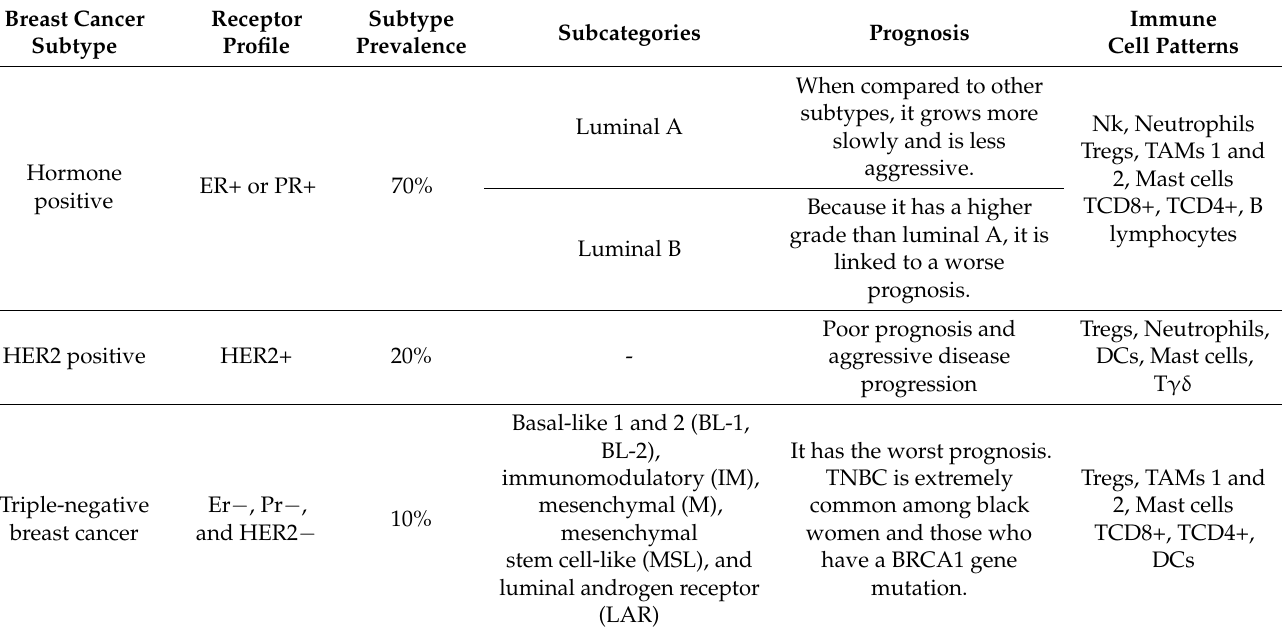
Table 1. In different breast cancer subtypes there is a link between their receptor profile, sub- type prevalence, subcategories, and the major infiltrating immune cell pattern. Immune cells are distributed differently in each subtype. The words in blue denote specific immune cells that are associated with a good prognosis, the words in red denote the infiltrating signature that is associated with a poor prognosis, and the words in green denote a lower proportion of immune cells that is also associated with a good